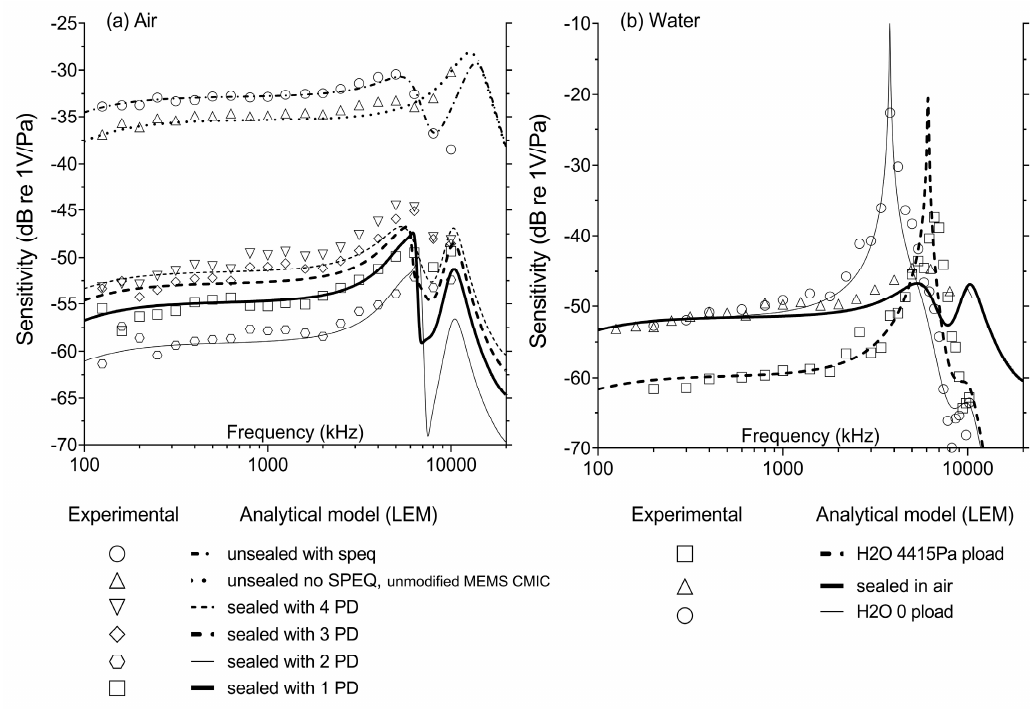
Figure 12. ( a ) Frequency response of the ADMP504 microphone sealed with one, two, three and four protective diaphragms (PDs) and operating in air. Markers: experiment, lines: analytical model (LEM). For comparison, the frequency response of the unsealed device equipped with and without (unmodified) a pressure port for static pressure equalization (SPEQ) is also shown. ( b ) Frequency response of the MEMS condenser microphone (MEMS CMIC) sealed with four PDs operating in water and in air. In addition, the frequency response of a sealed microphone that experiences the full hydrostatic pressure at a 0.5 m insertion depth is shown (p load = 4415 Pa).